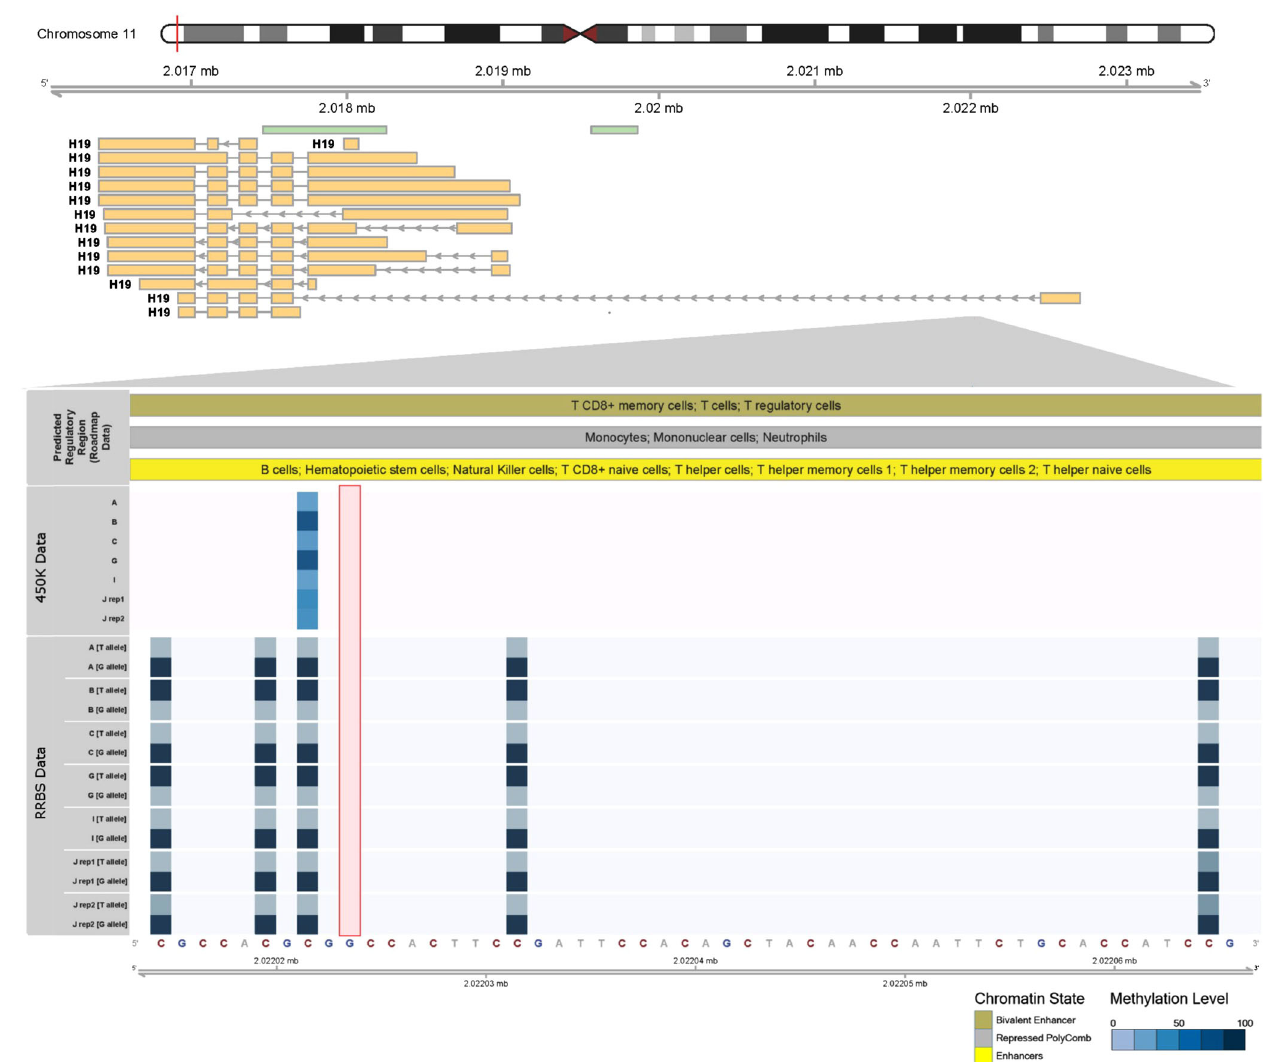
Fig. 6 Genotype and allele-speci fi c DNA methylation are measured by rmRRBS but not the In fi nium BeadChip. A diagram illustrating the position of the target region in H19 within the 11p15 imprinting region is shown at the top of the fi gure. The primary sequencing of DNA nucleotides appears at the bottom, with a G/T single nucleotide polymorphism (SNP) highlighted in a red box in the body of the fi gure. Monoallelic DNA methylation for the fi ve CpG loci covered by rmRRBS, as well as overall DNA methylation for the single CpG locus covered by the In fi nium HumanMethylation450 (450K) array, are shown for the six individuals (including one replicate of J) who were heterozygous for the G/T SNP with blue saturation of heatmap cells indicating DNA methylation levels. Predicted regulatory functions based on Epigenetic Roadmap chromatin state data is shown above the DNA methylation